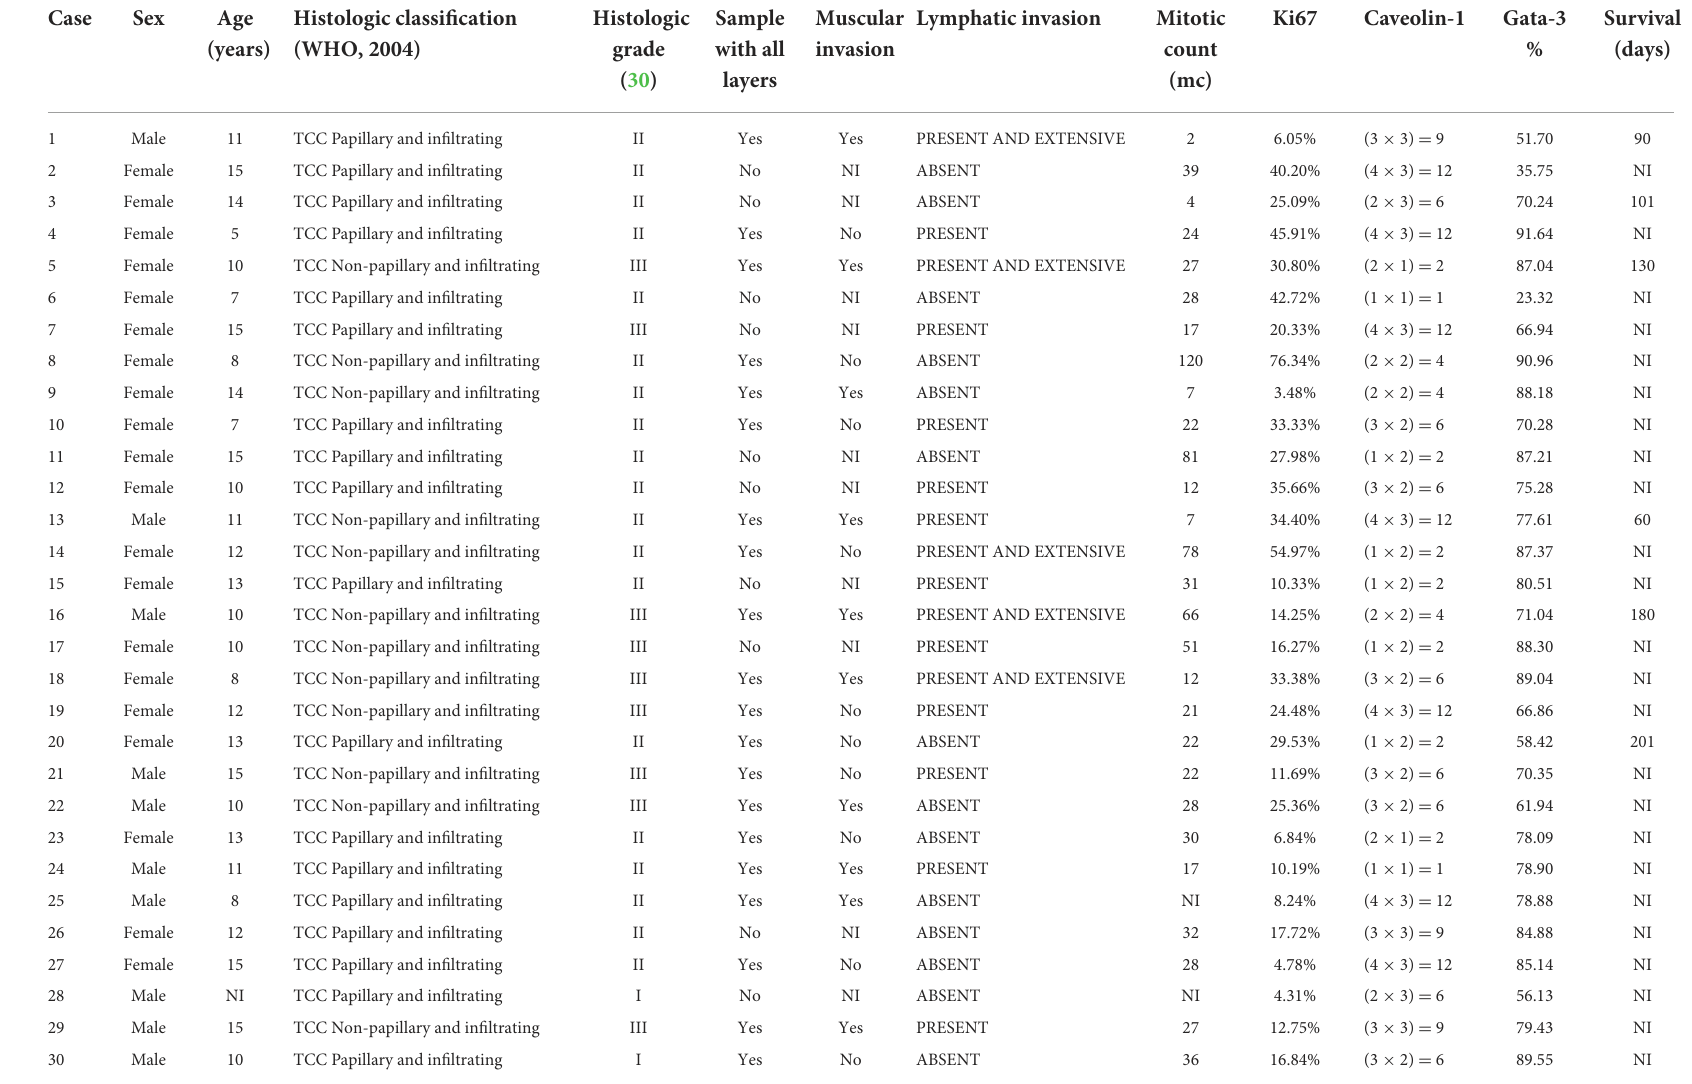
TABLE 1 Clinicopathological and immunohistochemical